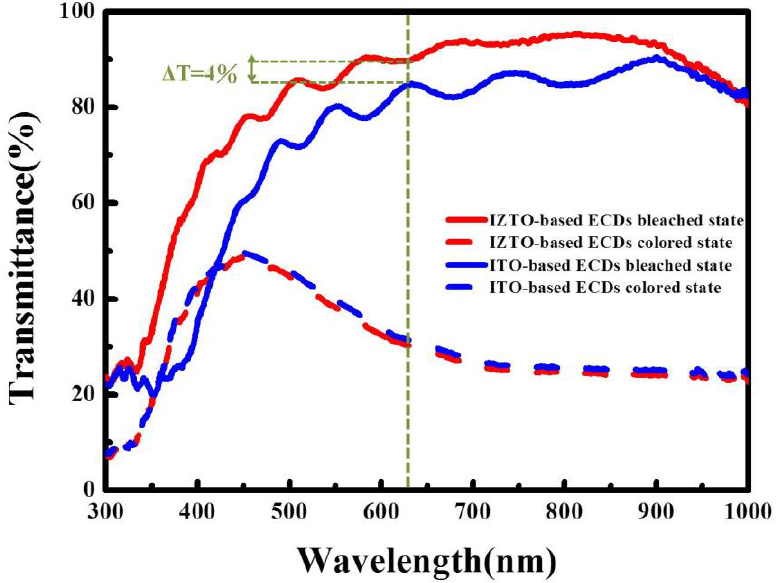
Figure 5. The transmittance of IZTO-based and ITO-based ECDs for bleaching and coloration states. FECDs involved the double injection/extraction of positive ions (lithium or proton) and electrons into/out of the host WO 3 lattice in the transition from W 5+ to W 6+ . This follows the electrochemical reaction: